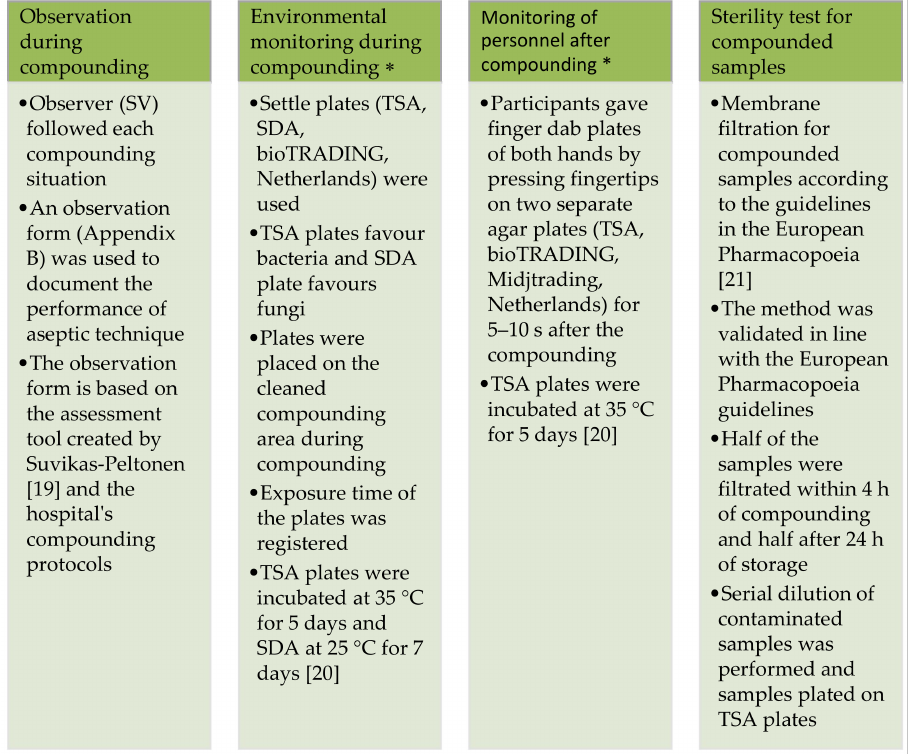
Figure 2. Study methods of observation, environmental monitoring, monitoring of personnel and sterility testing of product samples were used to evaluate the effect of aseptic technique and environ- ment on product sterility. TSA = tryptic soy agar, SDA = sabouraud dextrose agar. * European Union Good Manufacturing Practices (EU GMP) guidelines for recommended limits for microbiological monitoring of clean areas during operation were applied in the monitoring of environment and personnel